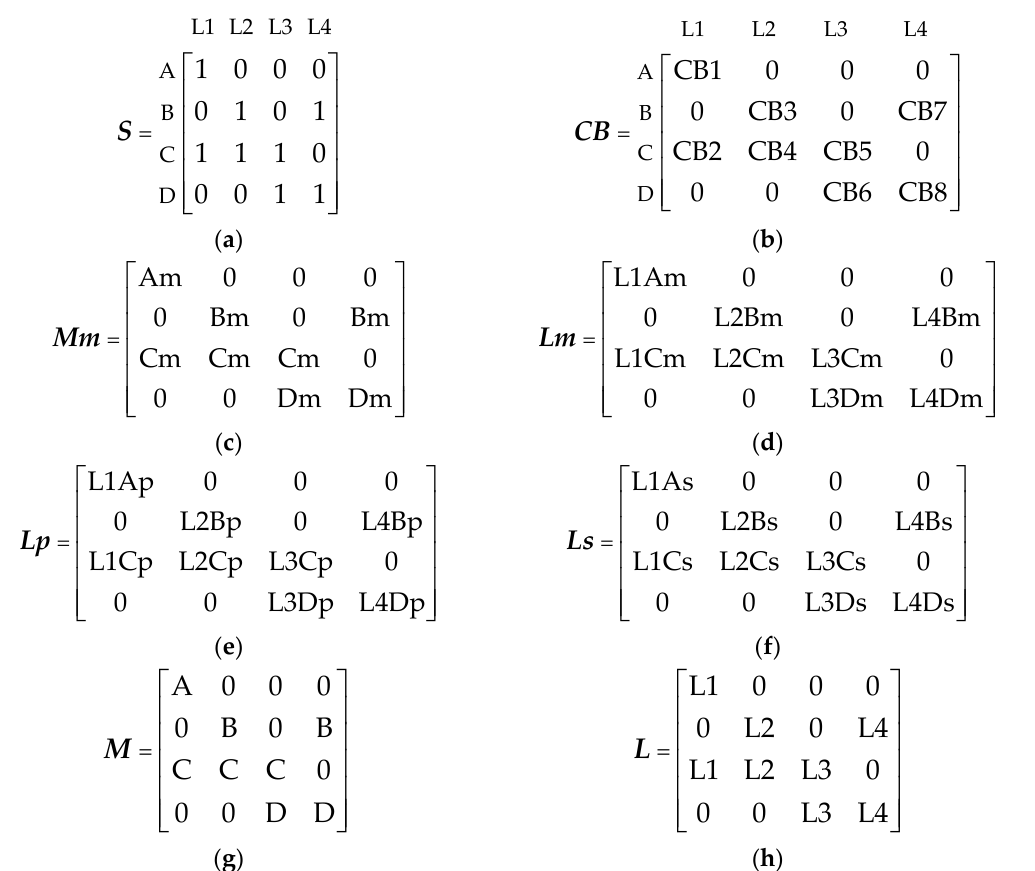
Figure 2. Topology description of the power system: ( a ) Incident matrix; ( b ) the circuit breaker matrix; ( c ) The bus protection matrix; ( d ) the main protection matrix; ( e ) the primary backup protection matrix; ( f ) the secondary backup protection matrix; ( g ) the bus matrix; ( h ) the transmission line matrix.